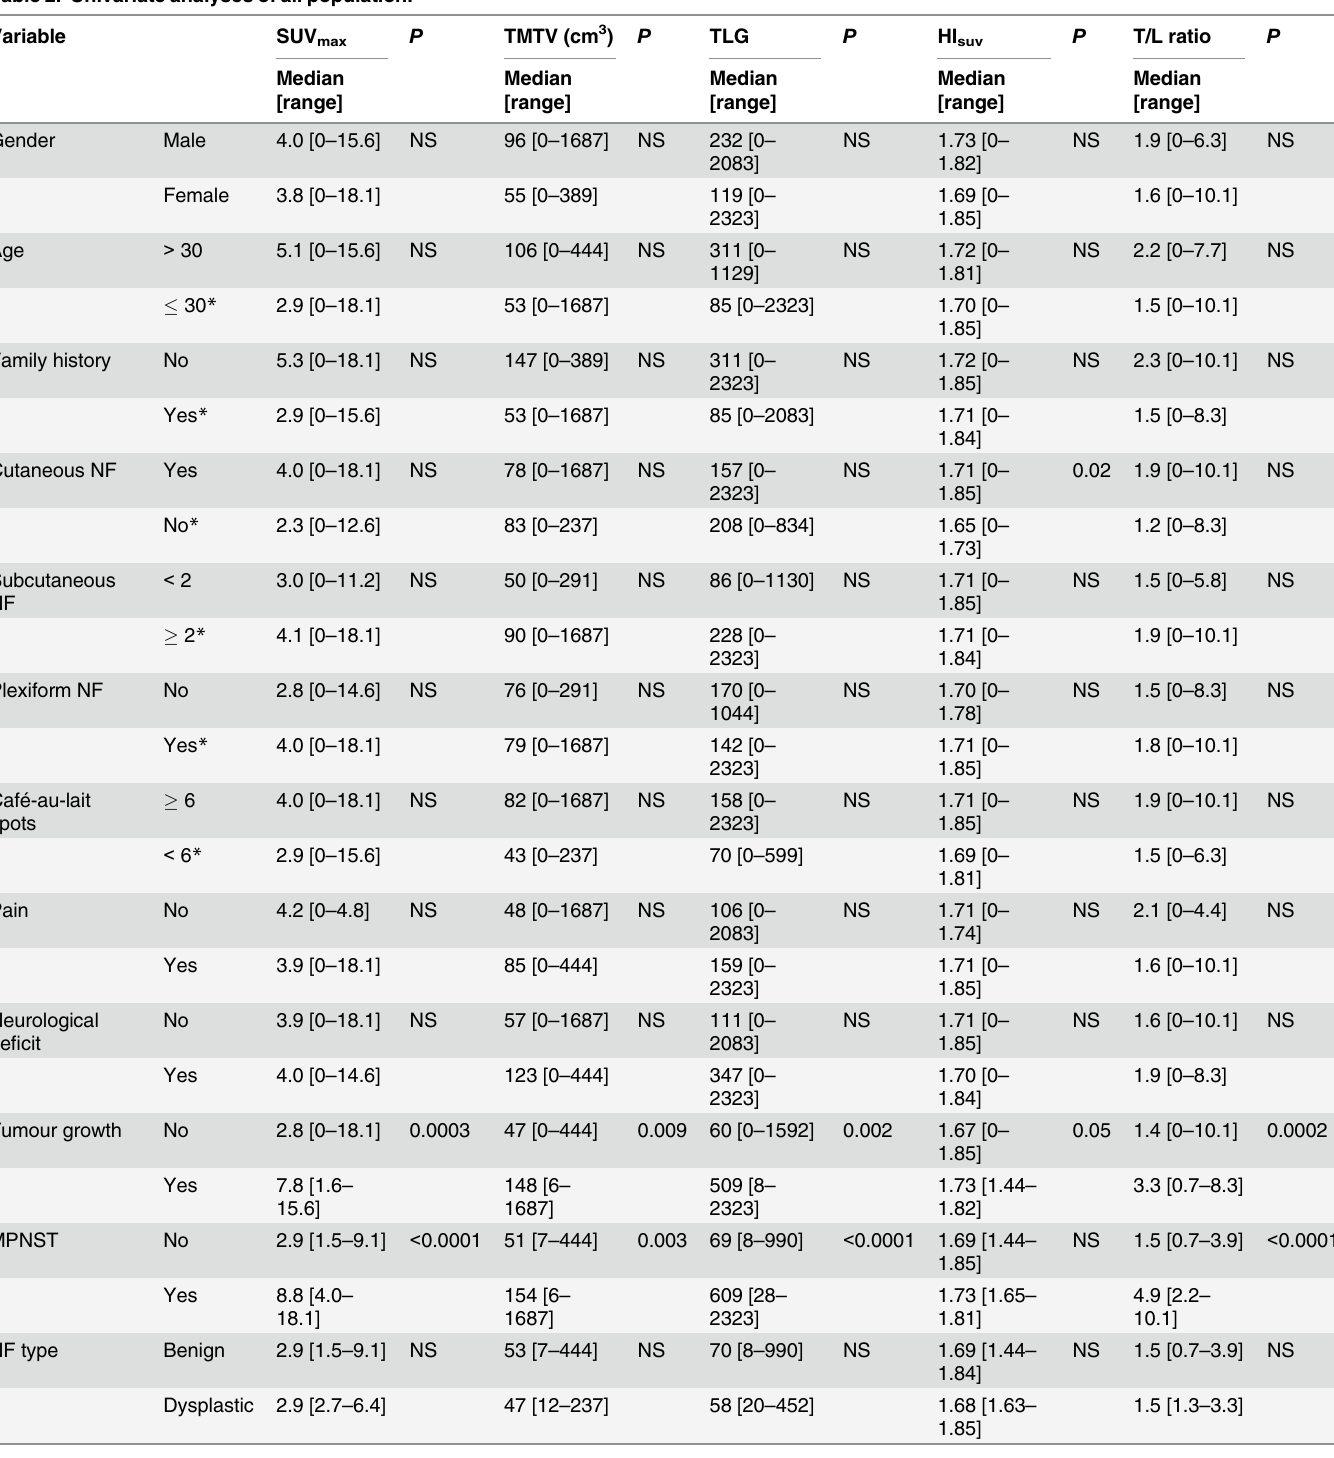
Table 2. Univariate analyses of all